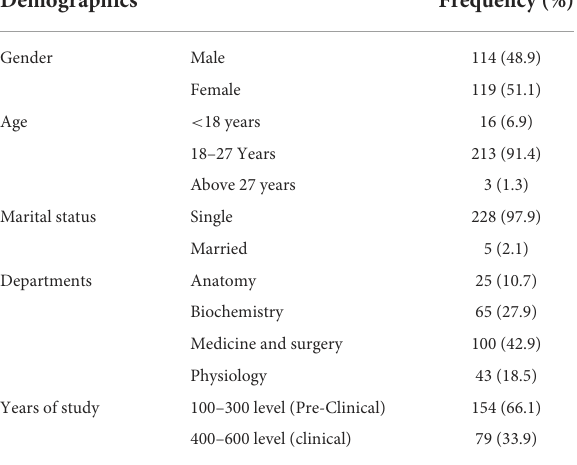
TABLE 1 Demographics of the study